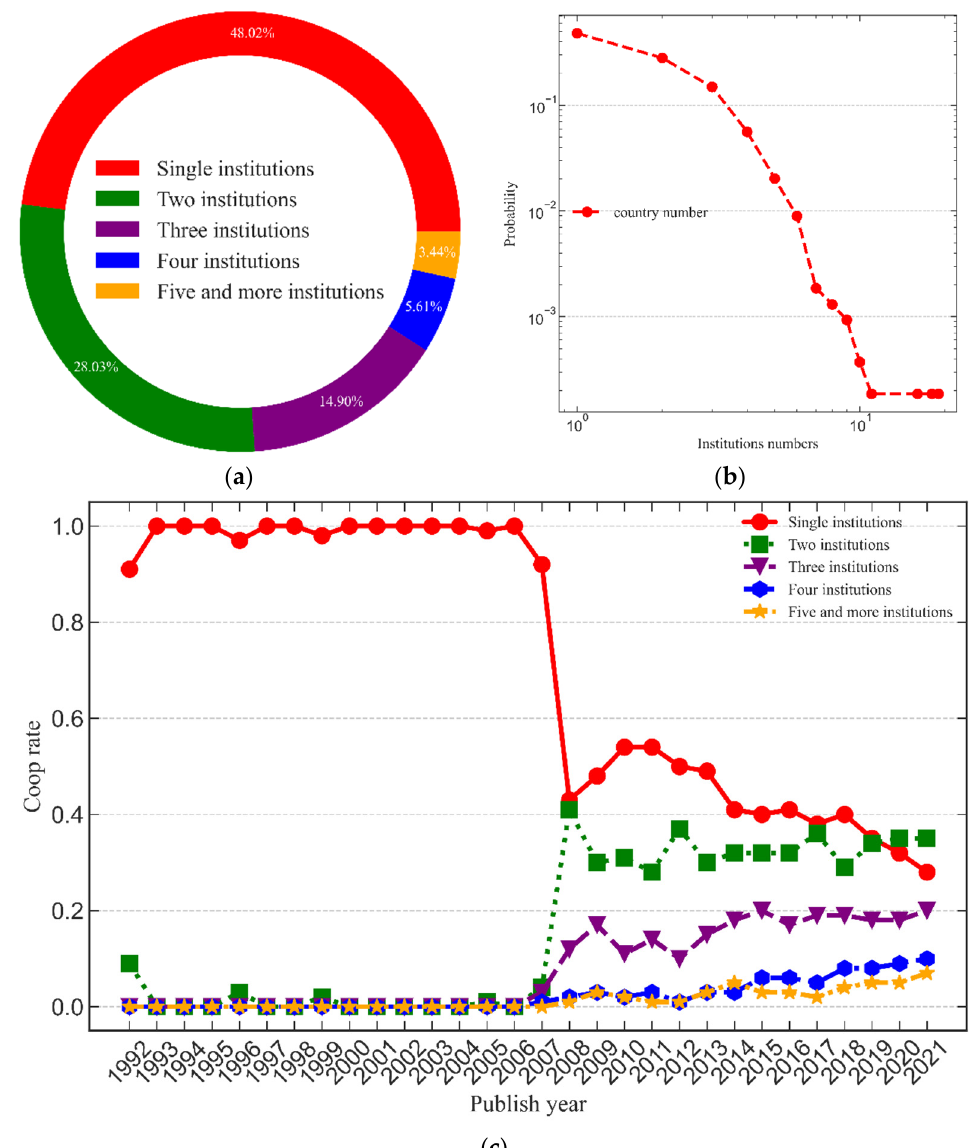
Figure 7. Institutional cooperation models in oil and gas wells. ( a , b ) The publication percentage and probability distribution produced by different institution teams. ( c ) Annual percentage changes in publications produced by different institution teams.